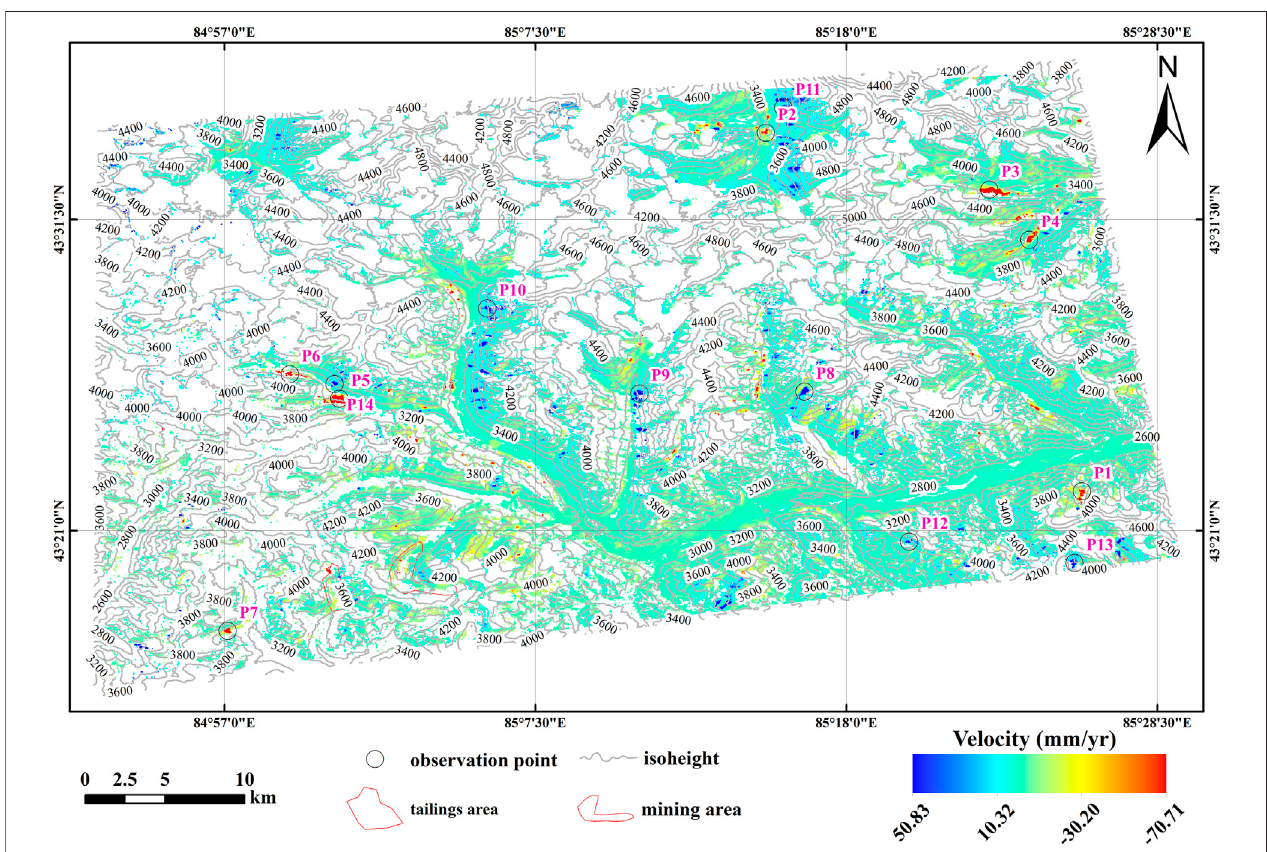
FIGURE 3 | Deformation velocity of the study area. 14 observation points were selected in areas of intensity deformation. An open-pit mining site is located in the southwest section (84.95 – 85.12 ° E and 43.28 – 43.35 ° N).